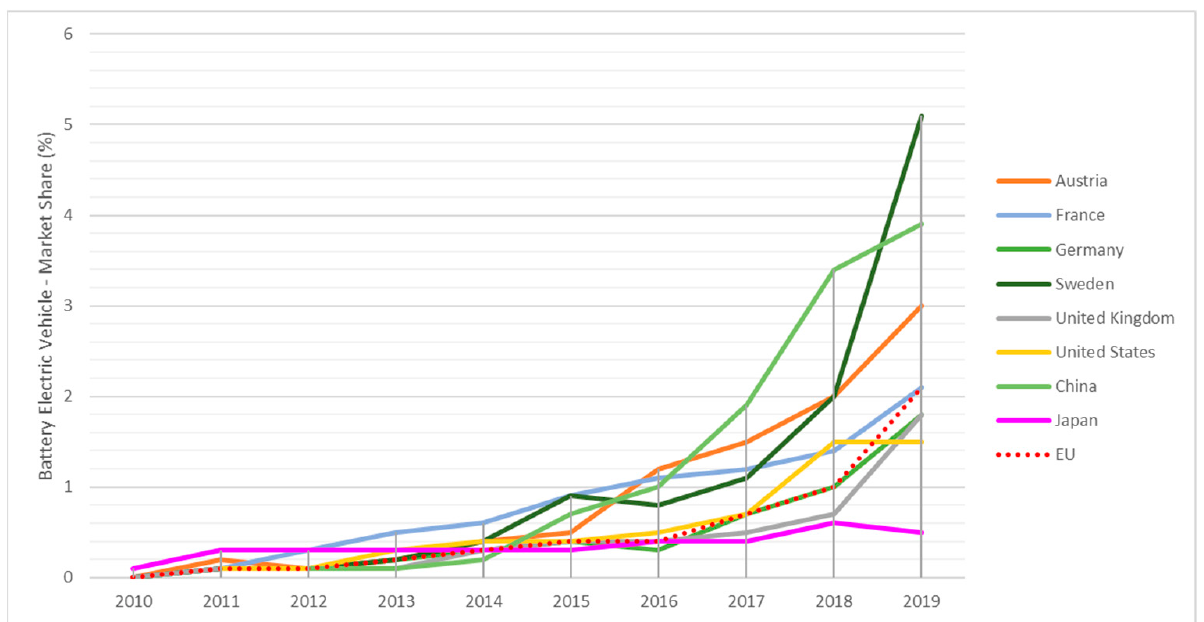
Figure 4. Battery electric vehicle market share in new registrations in major countries [36,37].